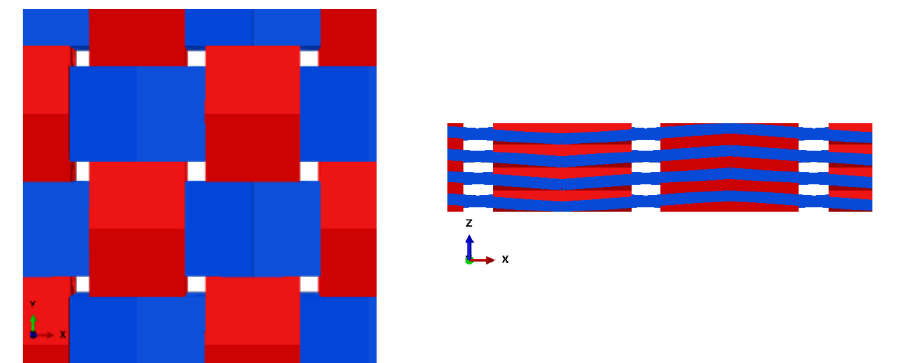
Figure 4 : Woven fibers modelled with rectangular section beams in